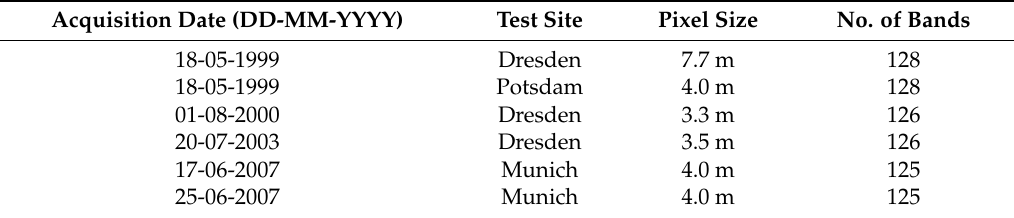
Table 1. Airborne imaging spectroscopy data used for the extraction of reference spectra for the BSL.